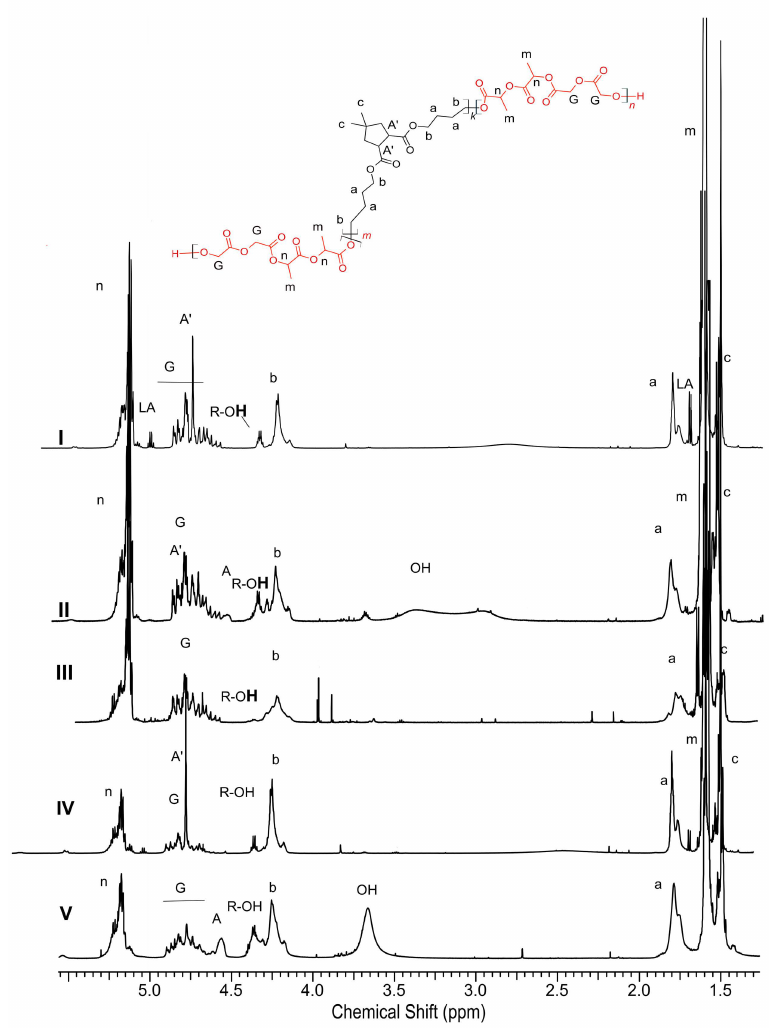
Figure 3. 1 H NMR spectra of the terpolymer obtained during copolymerization of L-lactide with gly- colide initiated by poly(butylene 2,3-O-Isopropylidene-l-tartrate): P1 terpolymer; ( I )—with protected OH groups; ( II )—after deprotection of OH groups; ( III )—with unprotected OH groups and after reaction with trichloroacetyl isocyanate, P2 terpolymer; ( IV )—with protected OH groups; ( V )—after deprotection of OH